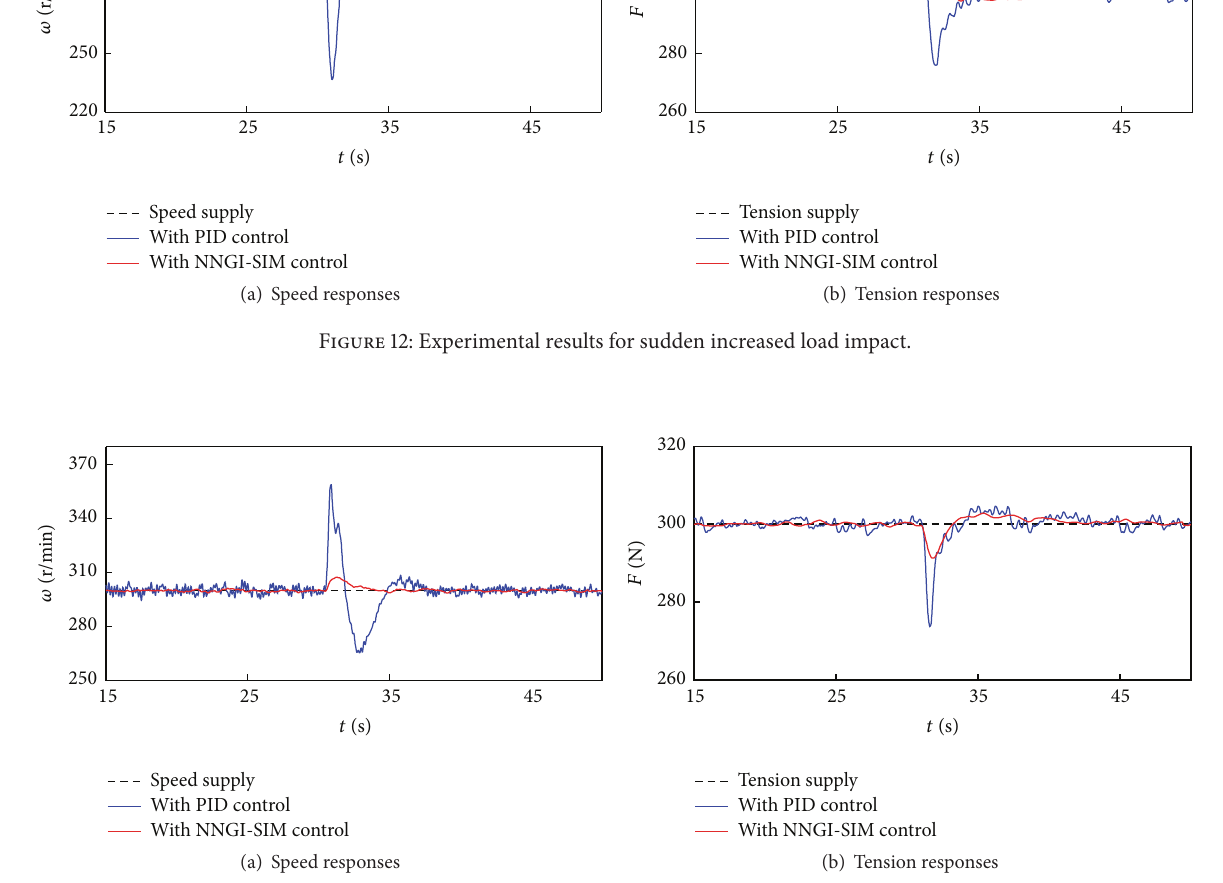
Figure 13: Experimental results for sudden decreased load